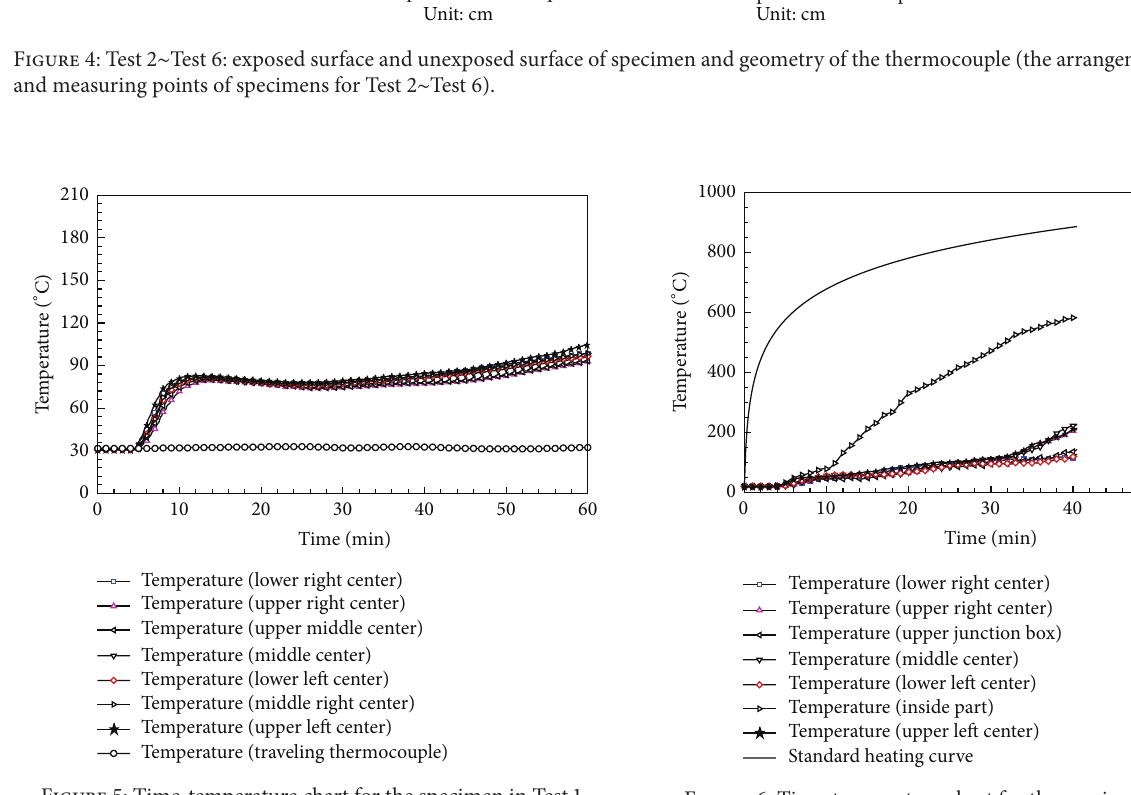
Figure 5: Time-temperature chart for the specimen in Test 1. Figure 6: Time-temperature chart for the specimen in Test